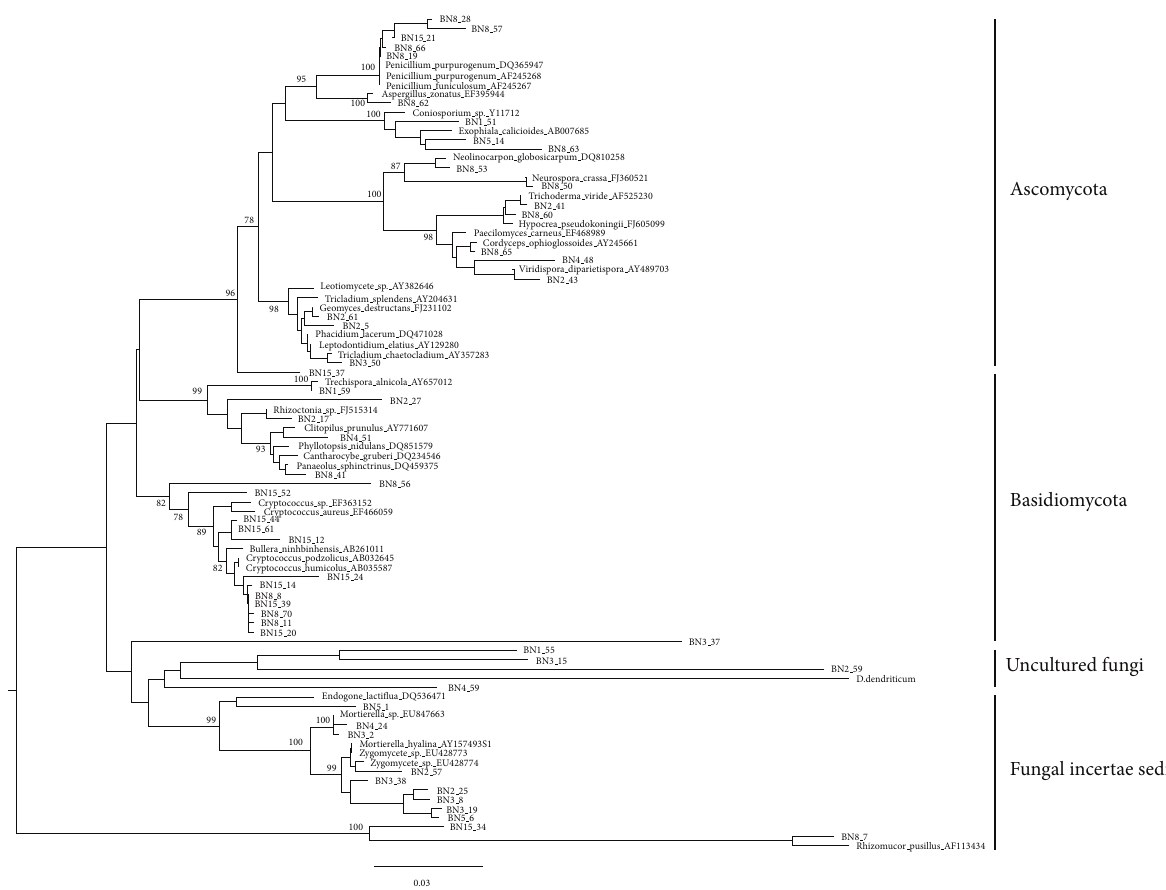
Figure 2: The phylogenetic relationships of fungal communities as compared to the most closely related sequences obtained from GenBank and RDP databases. The numbers at the nodes are the occurrence percentage with 1,000 bootstrap resamplings (values below 70% are not shown). The scale bar represents the number of changes per nucleotide